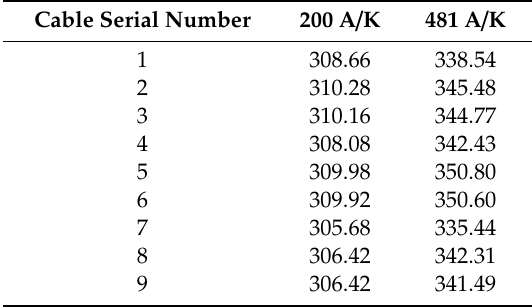
Table 3. Temperature of cable cores.